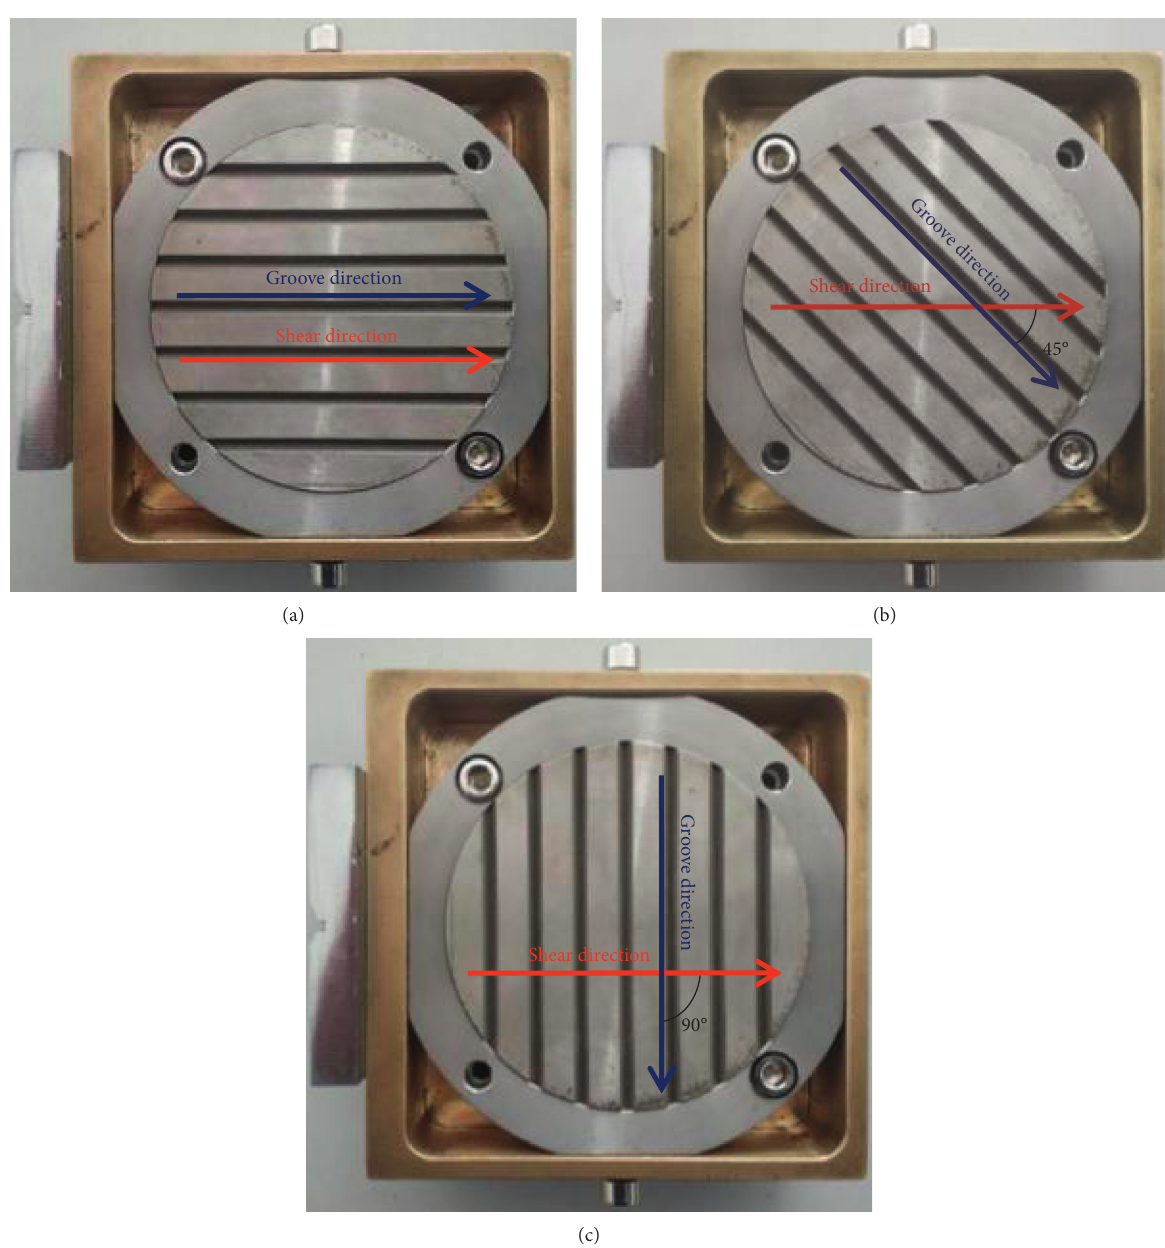
Figure 7: Groove angle of interface D . (a) 0 ° ; (b) 45 ° ; (c) 90 °